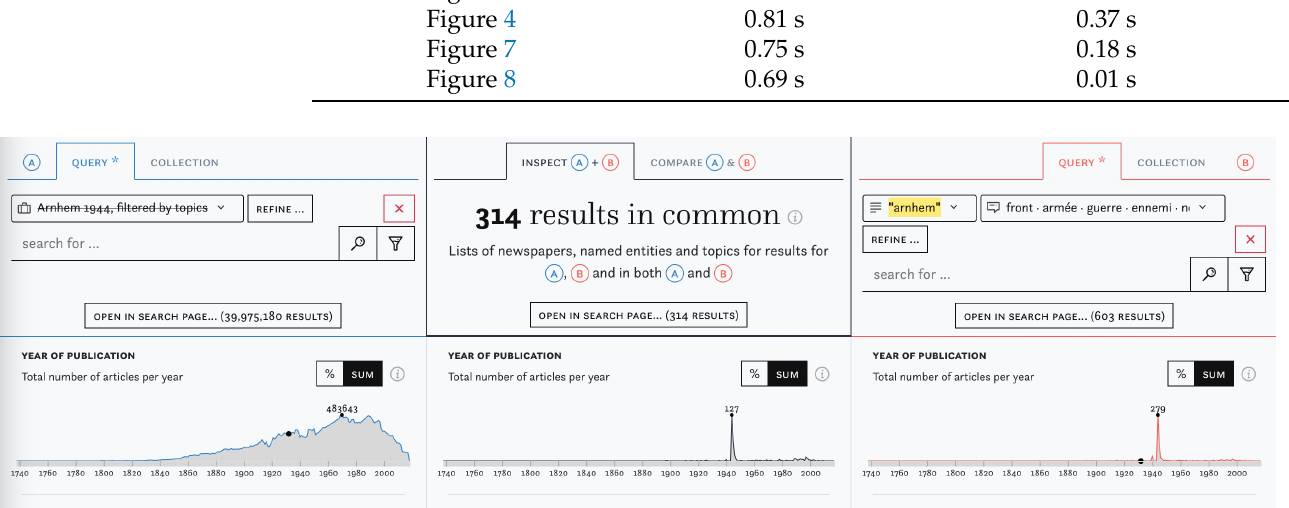
Figure 5. Identifying previously unknown articles by subtracting one set of articles from another.